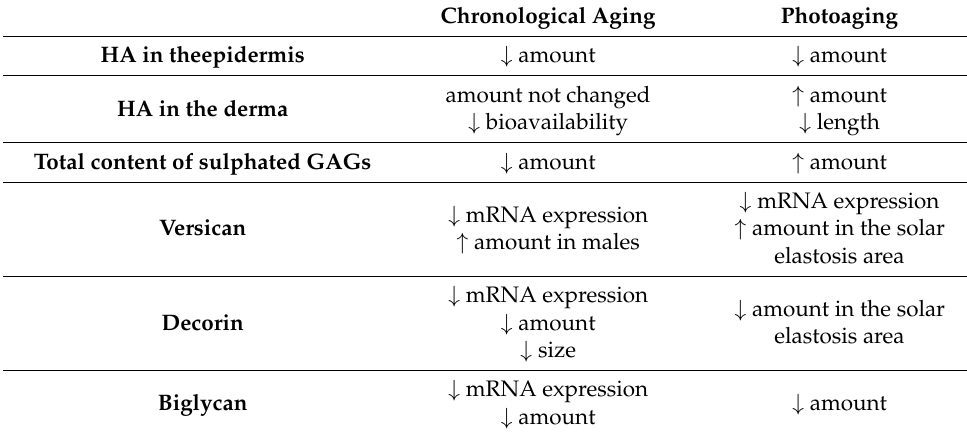
Table 1. Changes in glycosaminoglycans and proteoglycans in the skin with age. HA in theepidermis ↓ amount ↓ amount HA in the derma Total content of sulphated GAGs ↓ amount ↑ amount Versican Decorin Biglycan